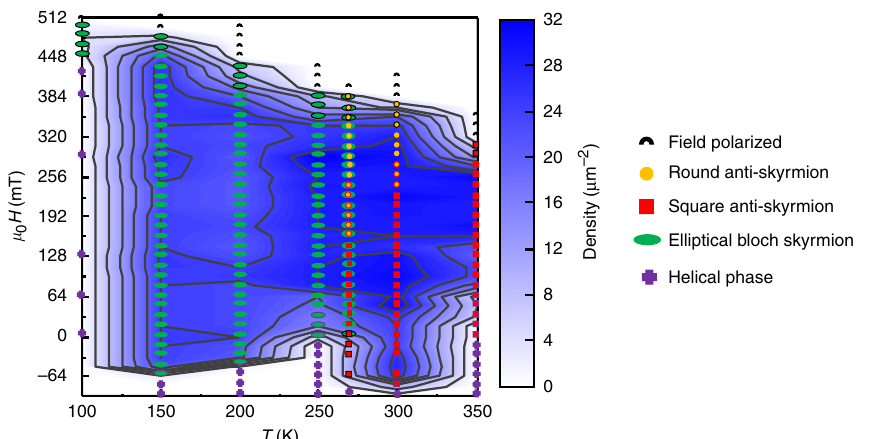
Fig. 7 Magnetic phase diagram. The observed magnetic textures form fi ve categories: fi eld-polarized state, round and square antiskyrmions, elliptical Bloch skyrmions and the helical phase, as indicated by the symbols shown in the fi gure. A mixed phase is shown by the corresponding symbol with an appropriately colored edge. The contour plot in the background shows the density of skyrmionics and antiskyrmionic objects. This phase diagram corresponds to a ~170-nm-thick sample with a tilted- fi eld protocol as follows: at a given temperature the fi eld is decreased, starting from the fi eld-polarized phase, in steps of a few mT, then the sample is tilted ~40° away from the pole direction, and fi nally tilted back and the LTEM image is taken. Once a dense array of skyrmions or antiskyrmions is found, the fi eld is subsequently decreased without any tilting. At 268K we observe the coexistence of skyrmions and antiskyrmions (cf. Fig.